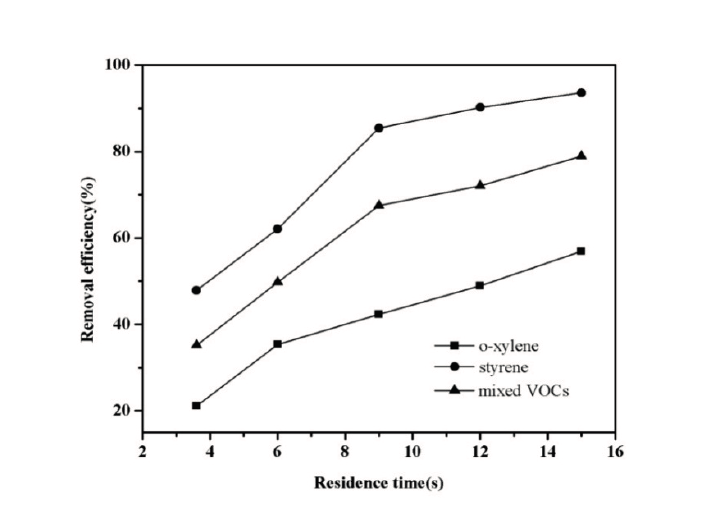
Figure 4. Influence of residence time on the decomposition of mixed